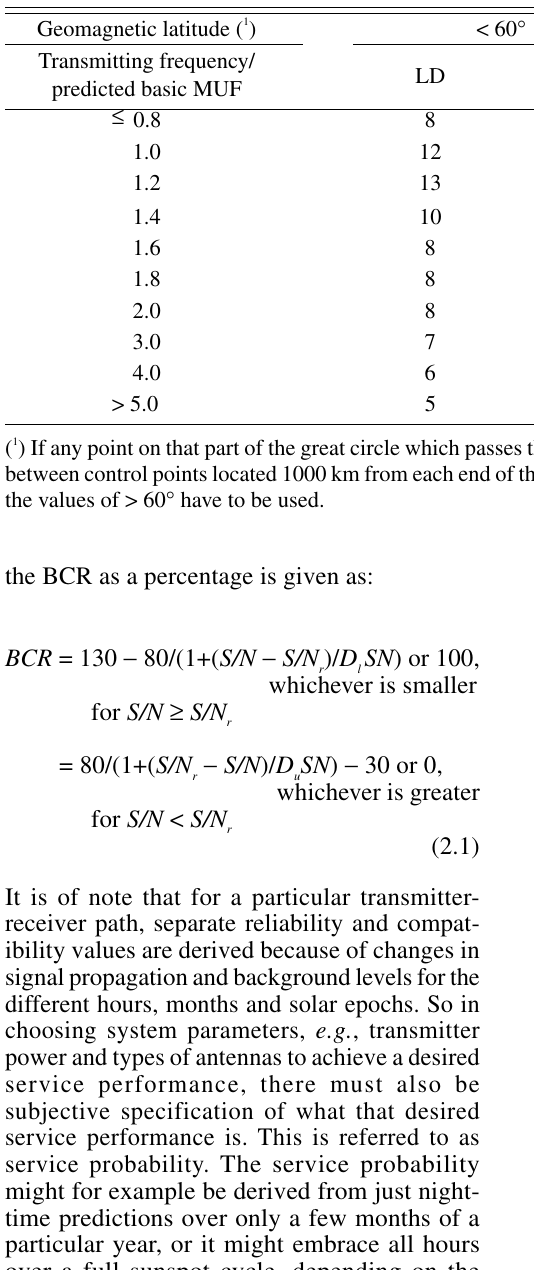
Table I. Lower Decile (LD) and Upper Decile (UD) deviations from the predicted monthly median value of available receiver power of the wanted signal and interfering signals, arising from day-to-day variability. Geomagnetic latitude ( 1 )